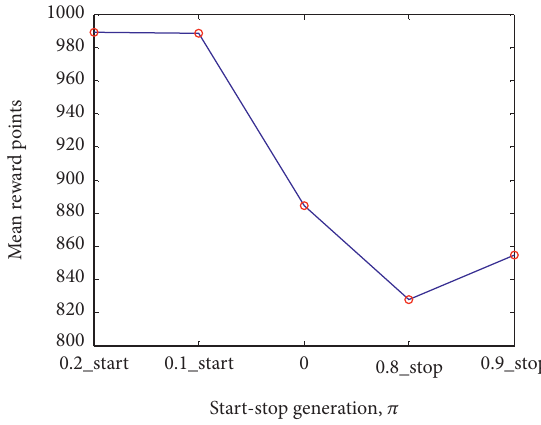
Figure 5: Mean reward points for different start-stop generations ( φ